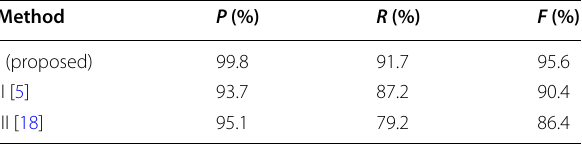
Table 7 The details of the number of people, except the target, in the on-line